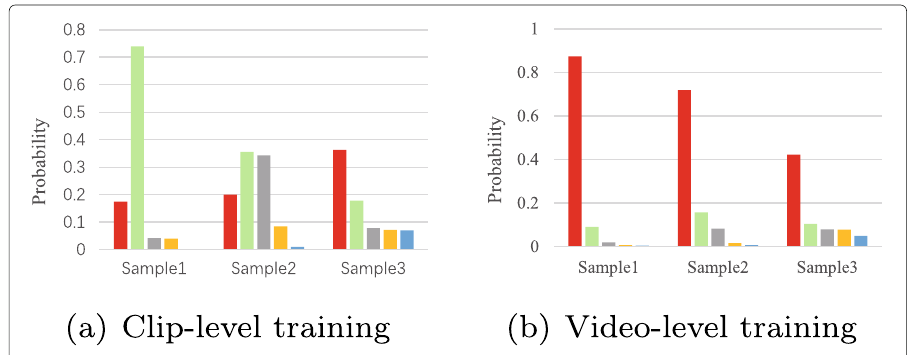
Fig. 8 Visualization of action recognition result on top 5 probabilities